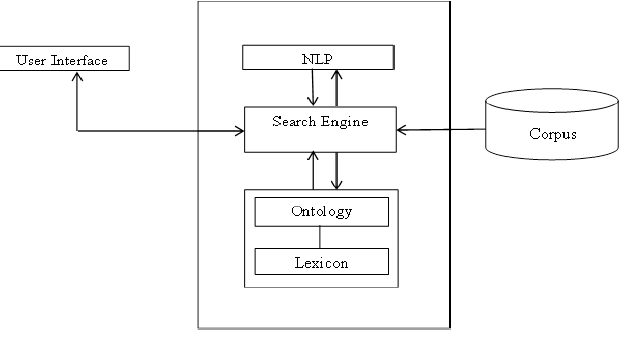
Fig. 1. The proposed Torch architecture.